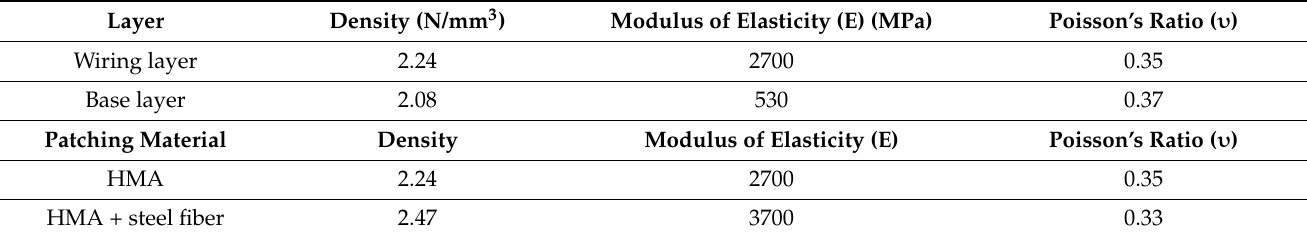
Table 11. Mechanical properties of pavement